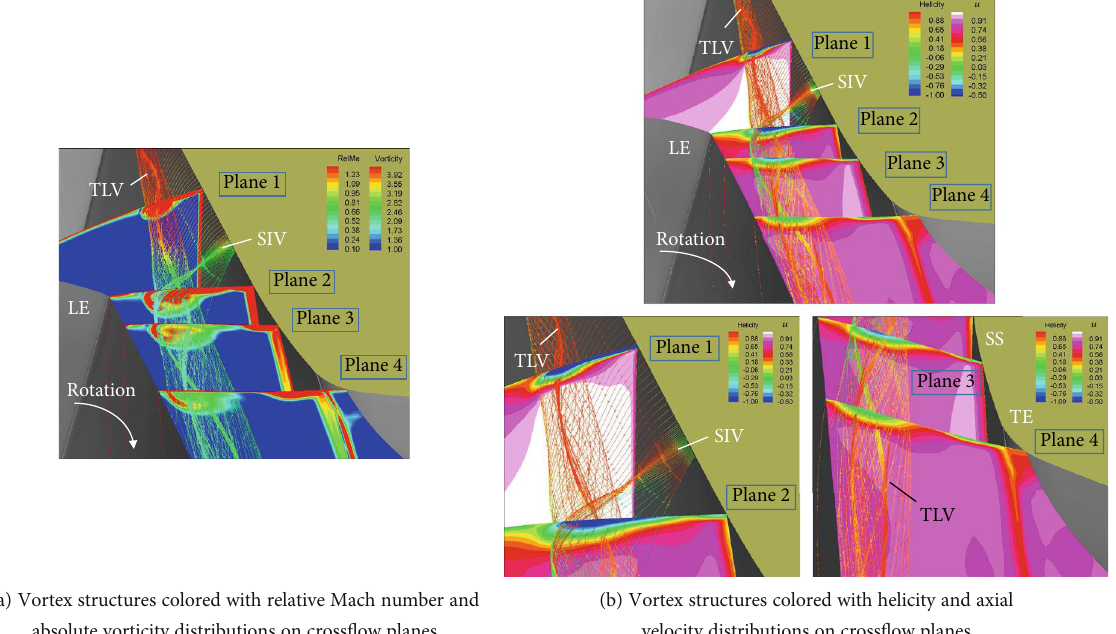
Figure 19: Characteristics of shock-induced vortex stability at near stall condition for Rotor